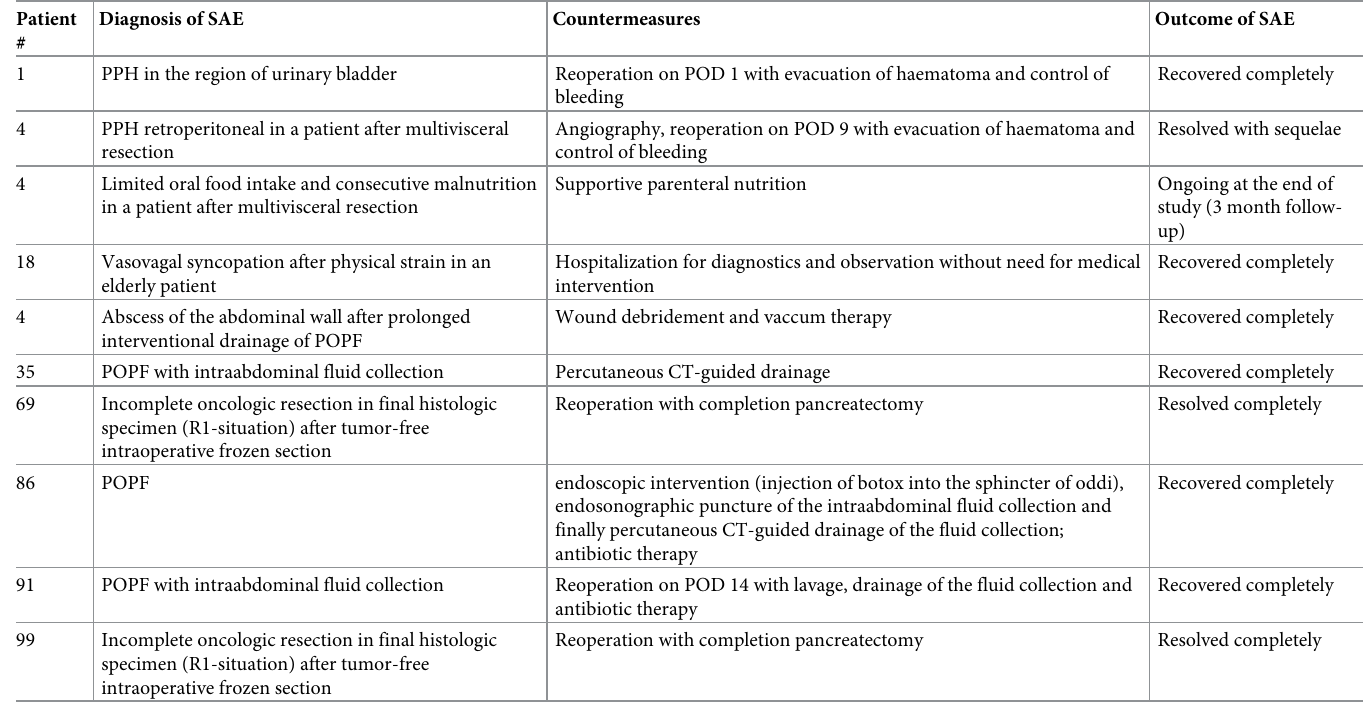
Table 3. List of serious adverse events and their